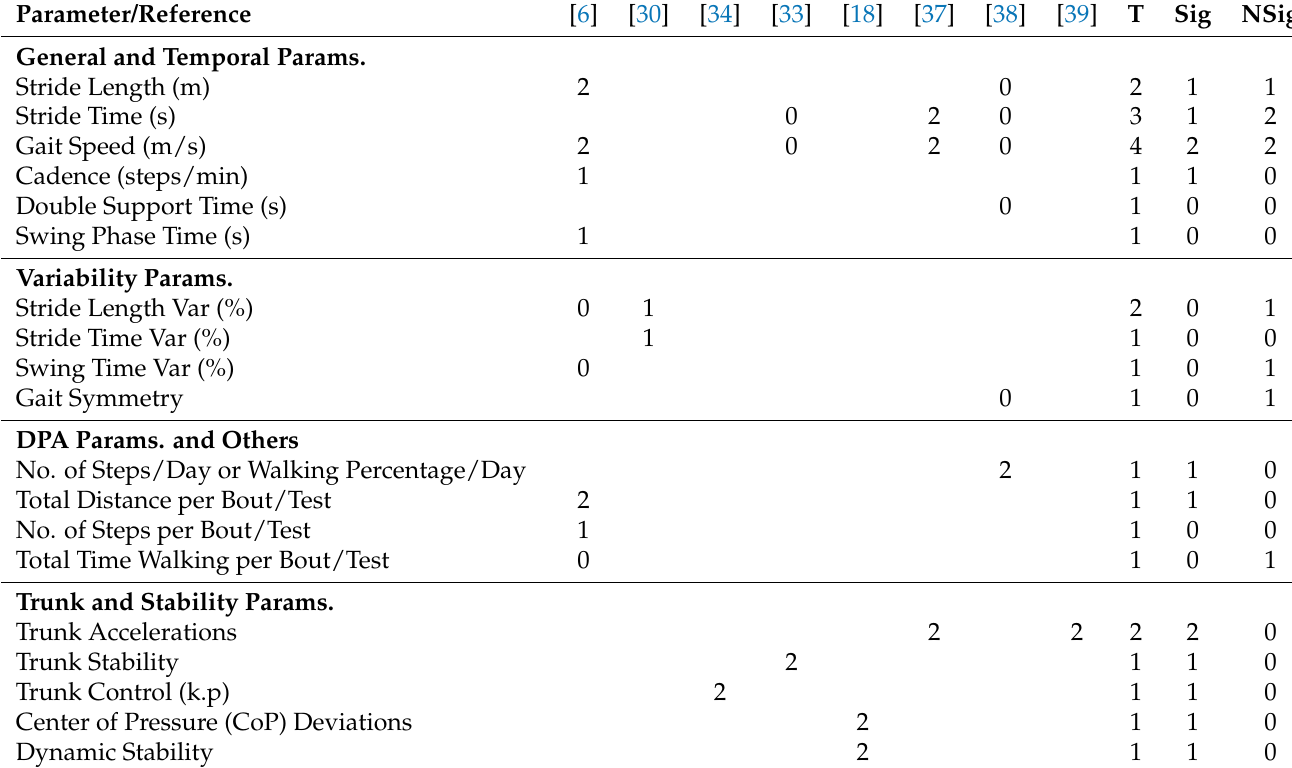
Table 5. Gait parameters related to fall risk. The parameters are rated from 0 to 2 for each article, where 0: nonsignificant, 1: studied and more or less significant, and 2: significant or discriminant. T: number of total Times that each parameter is included, Sig: number of times that each parameter is considered “Significant”, and NSig: number of times that a parameter is considered as “Nonsignificant” between fall risk